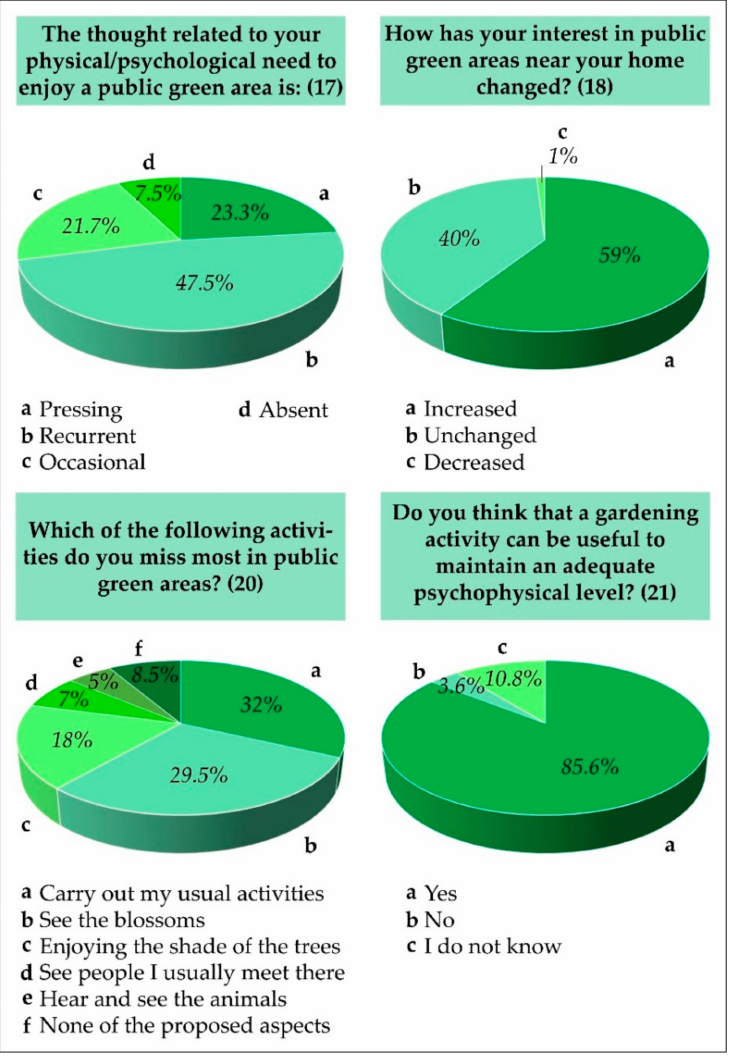
Figure 3. Perception of public green areas during the social distancing period (questions 17, 18, 20, and